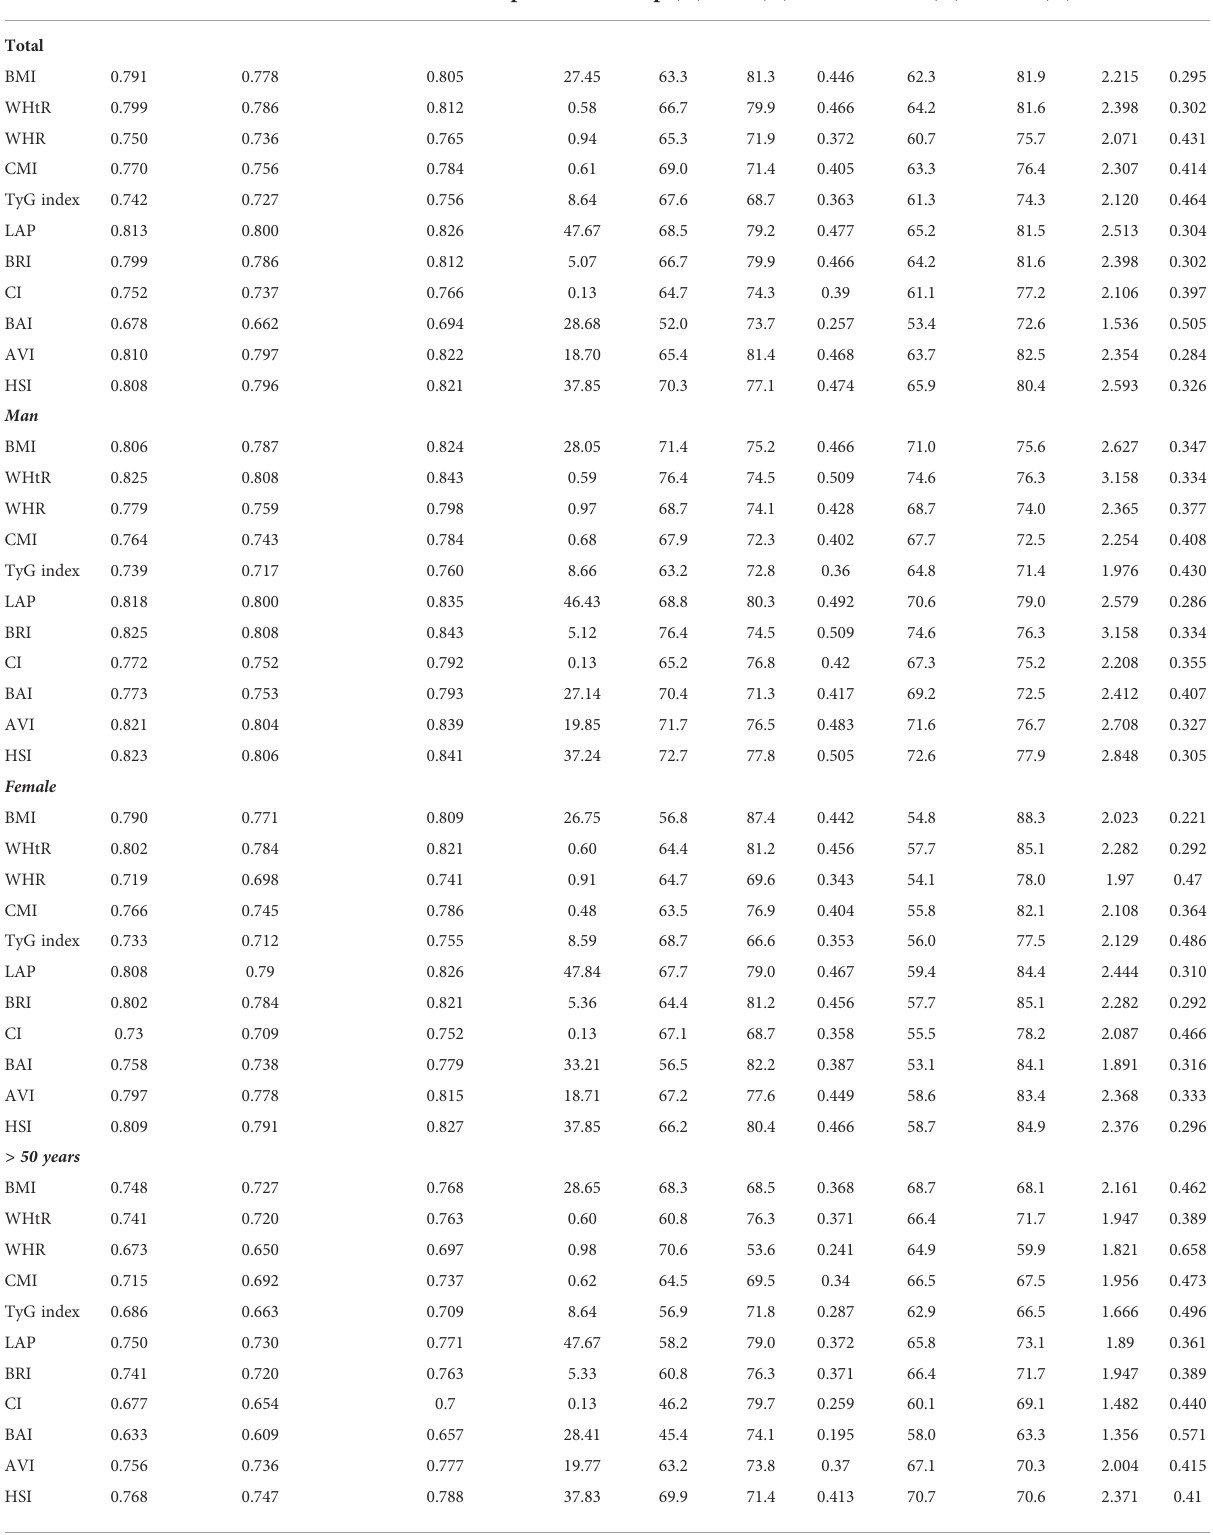
TABLE 5 Diagnostic performance of anthropometric indices for the detection of